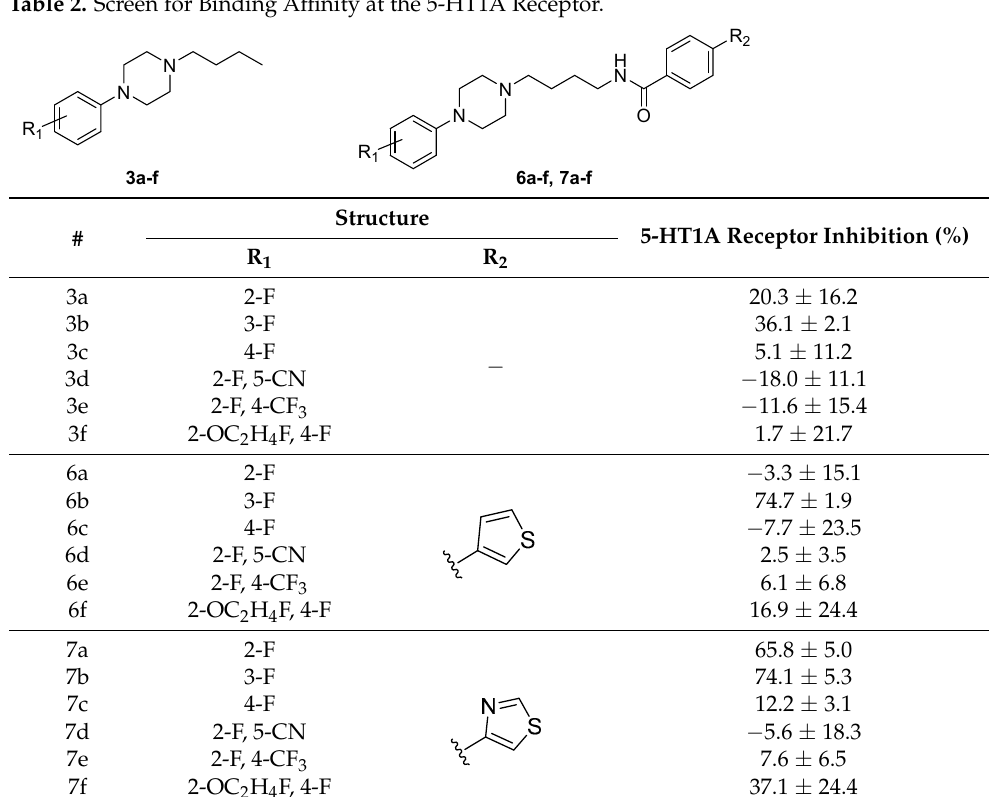
Table 2. Screen for Binding Affinity at the 5-HT1A Receptor.